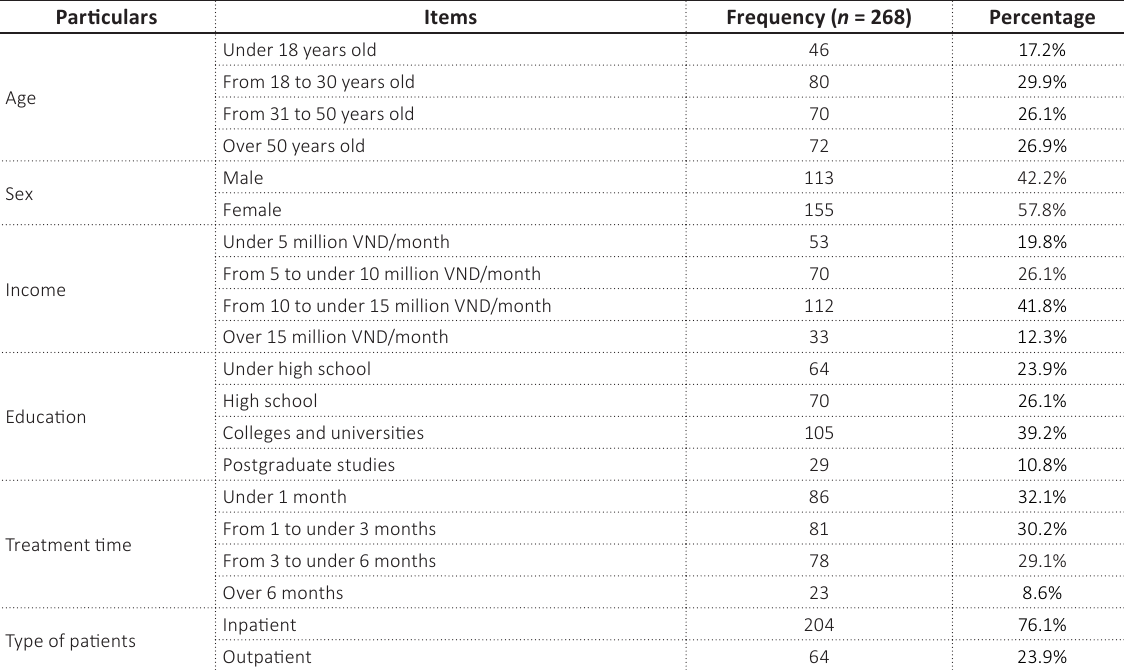
Source: Developed by the authors.